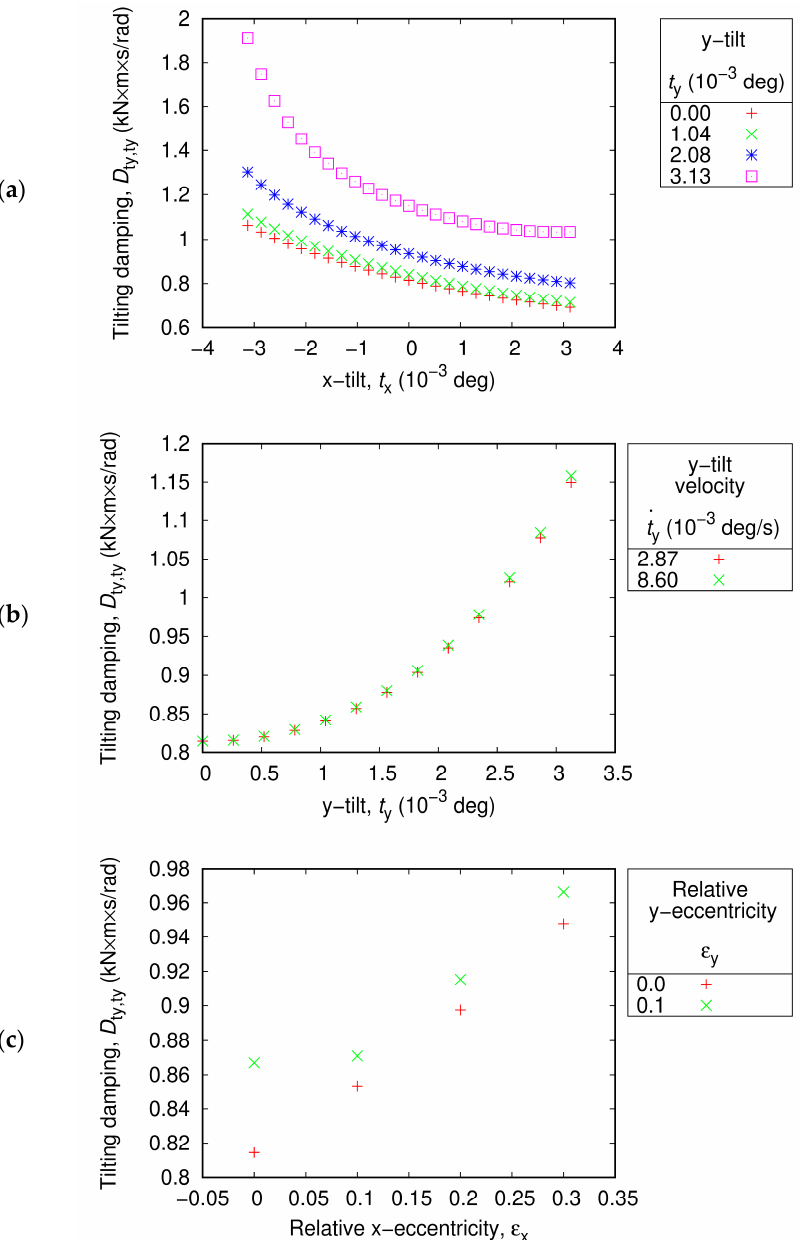
Figure 11. Parameter sensitivity of the direct damping coefficient D ty , ty : ( a ) Effects of x and y tilting angles; ( b ) Effects of the tilting angle and tilting velocity in the y-direction; ( c ) Effects of relative eccentricities. All unreferenced parameters have zero values.